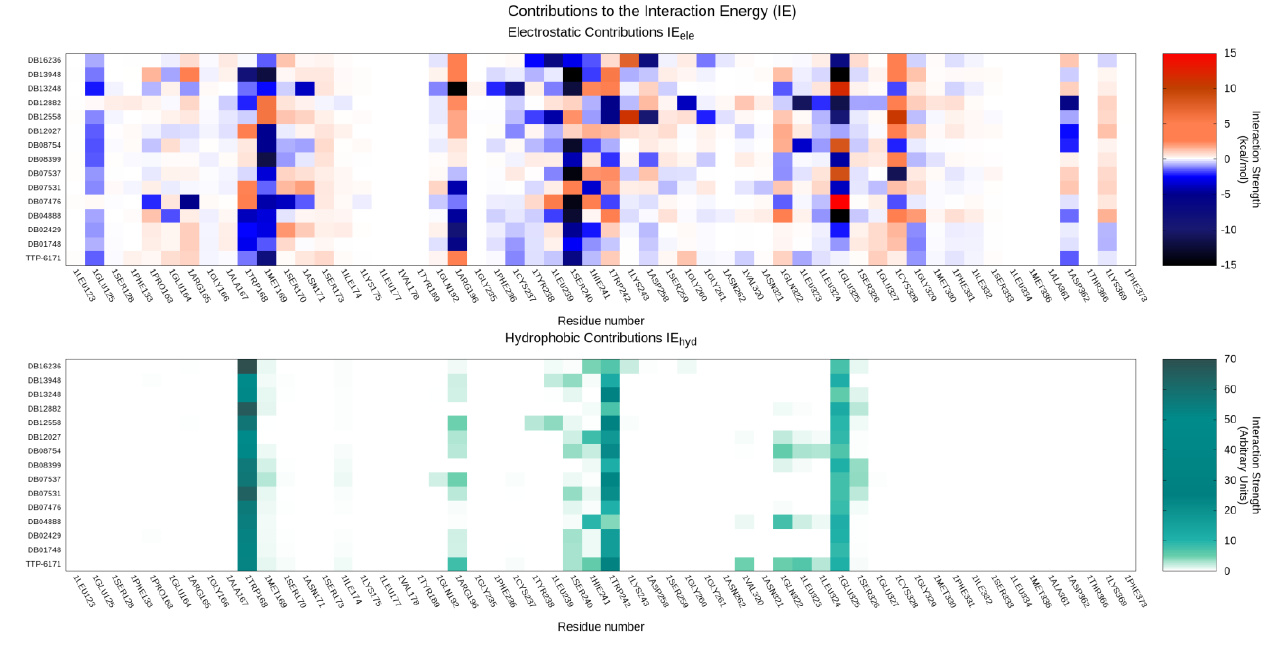
Figure 6. Per-residue decomposition of the main contributions to the protein-ligand interaction energy for both the reference TTP-6171 and query compounds identified through the docking-based virtual screening: the upper panel highlights electrostatic interactions, while the lower panel showcases hydrophobic interactions.